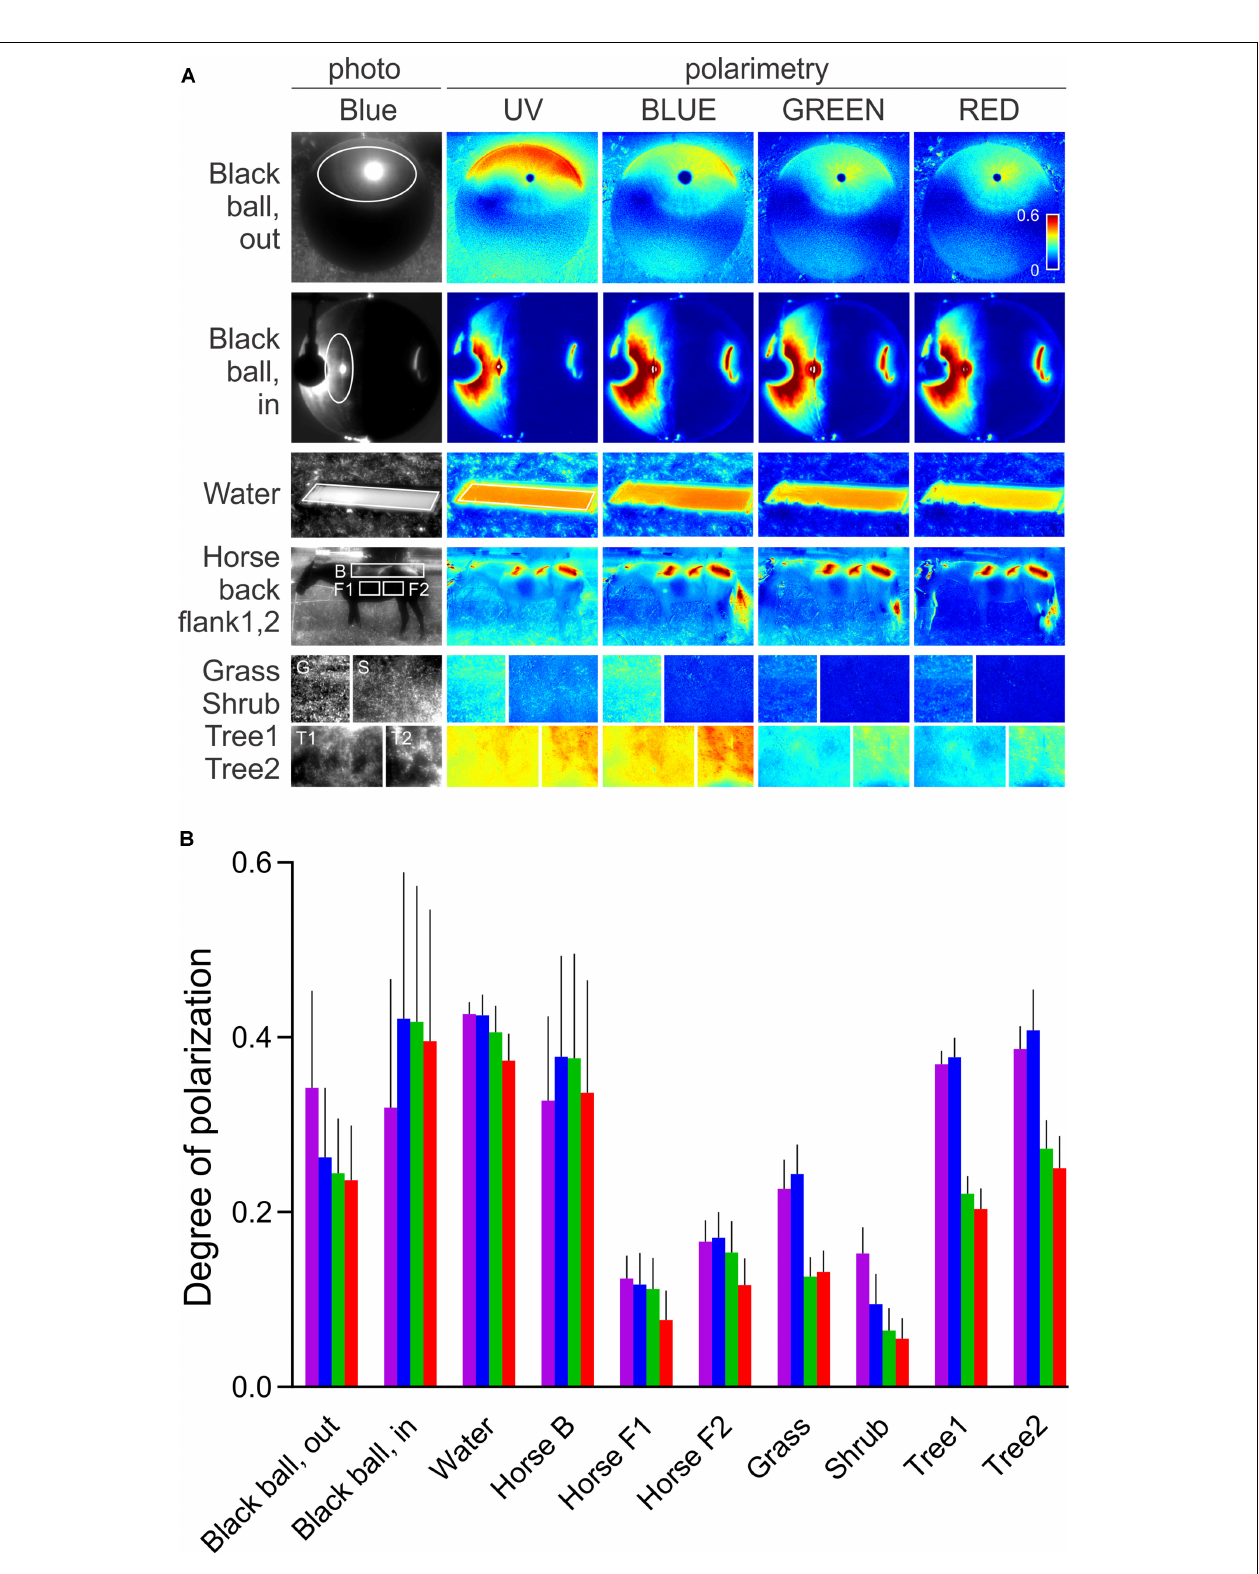
FIGURE 2 | Spectral dependence of DOP of a horsefly trap (black shiny ball), water surface, fur of a black horse, and vegetation. (A) Polarimetric images (columns 2–5); DOP in UV, blue, green, and red, presented with false colors; regions of interest are marked with ellipses and rectangles in the non-polarimetric photograph in the blue channel (column 1). (B) DOP of regions of interest in (A,B) . Colors of bars correspond to the spectral bands. Error bars correspond to standard deviation.